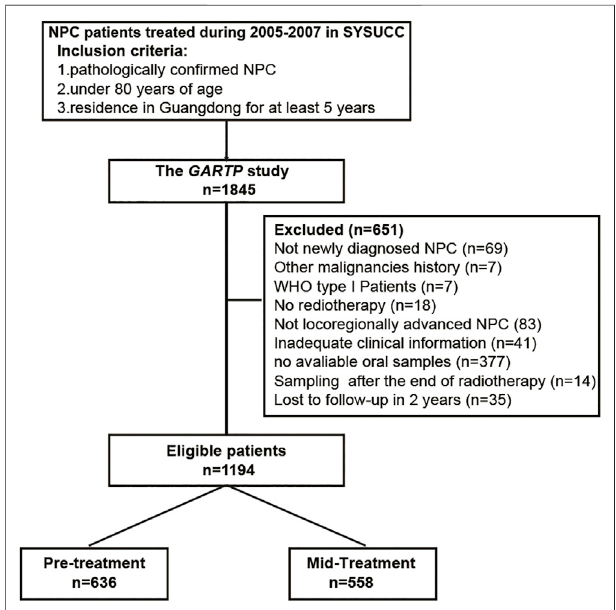
FIGURE 1 | Flowchart of patient inclusion and exclusion. NPC (cid:1) nasopharyngeal